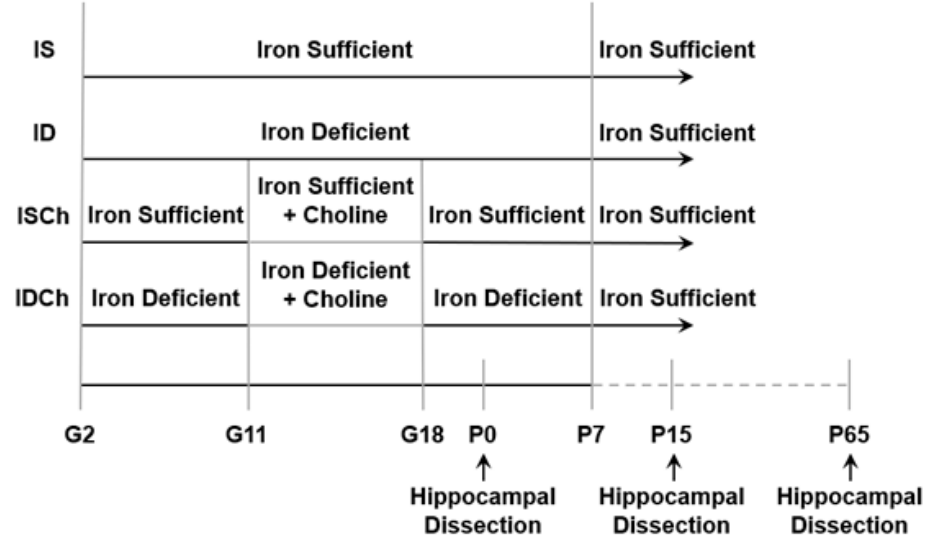
Figure 1. Graphical diagram of experimental groups. Abbreviations: Gestational day (G), iron-deficient group (ID), iron- deficient with choline supplementation group (IDCh), iron-sufficient group (IS), iron-sufficient with choline supplementation group (ISCh), and postnatal day